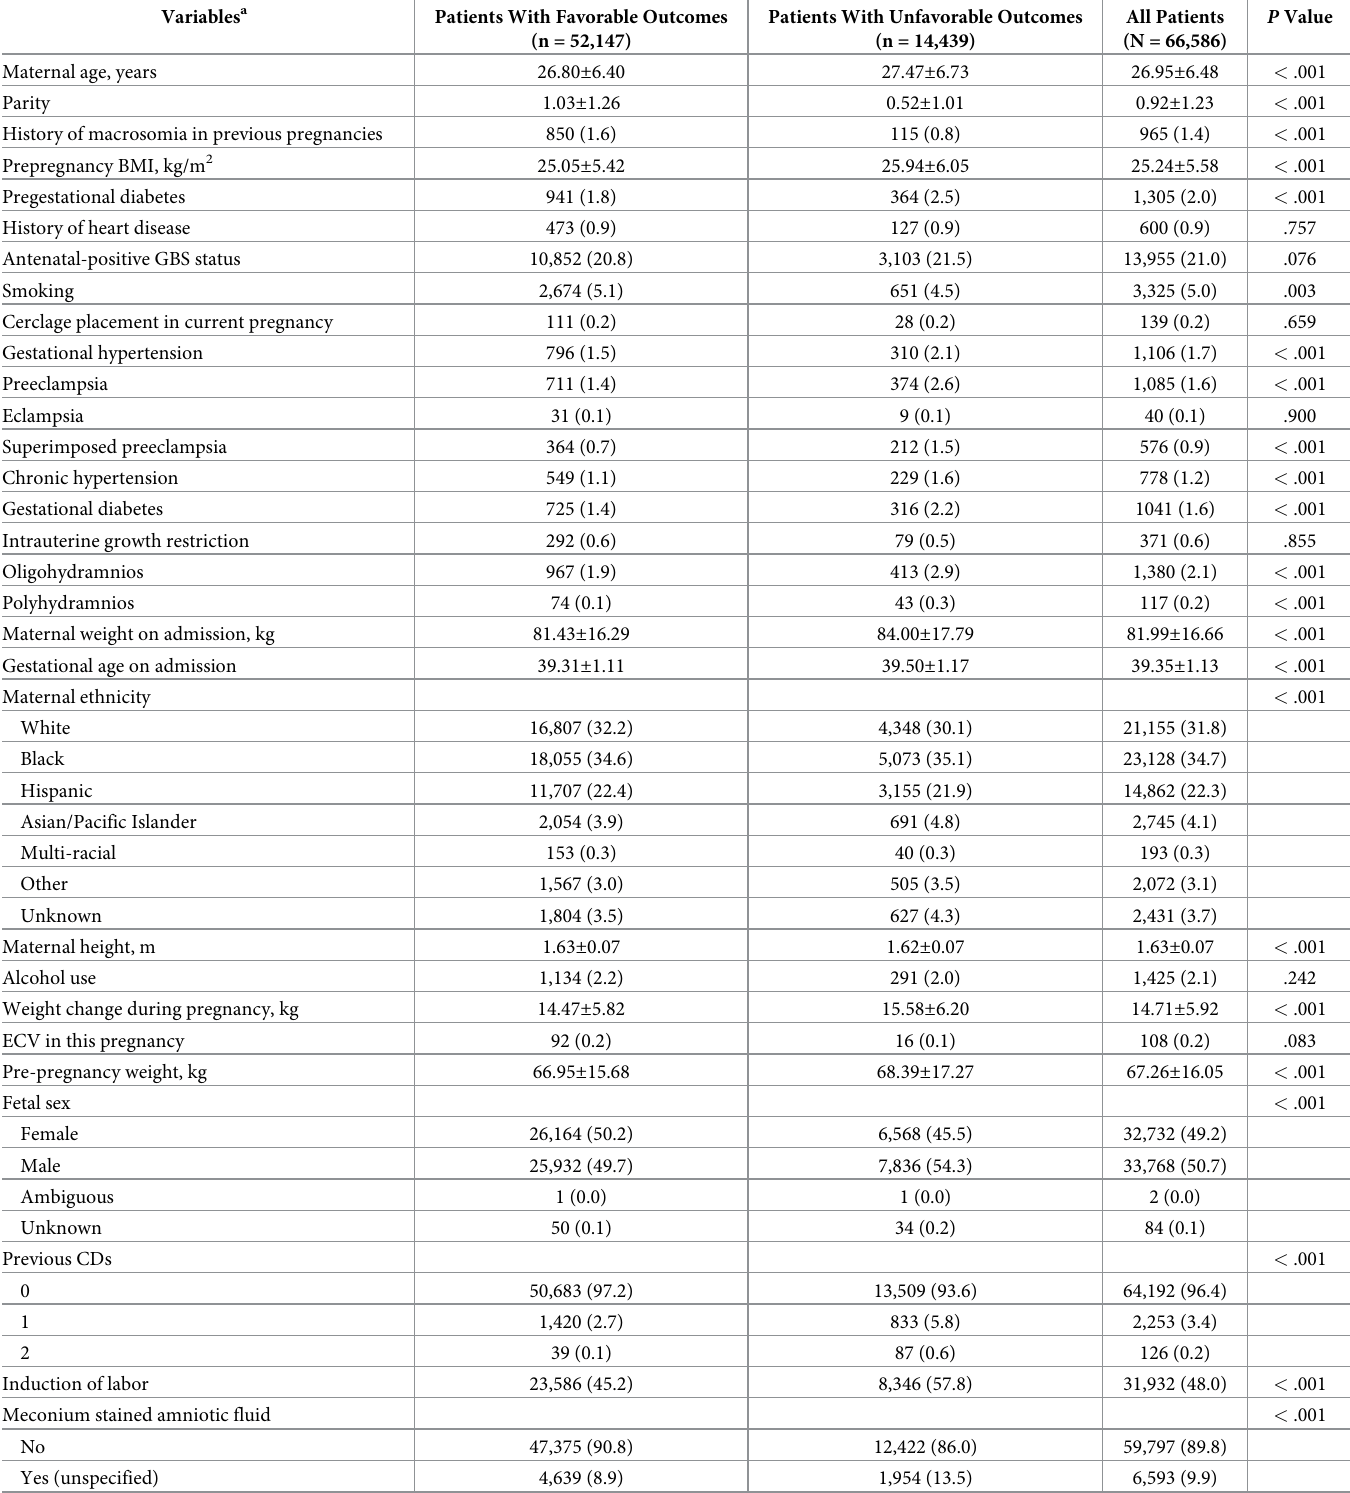
Table 1. Characteristics of eligible